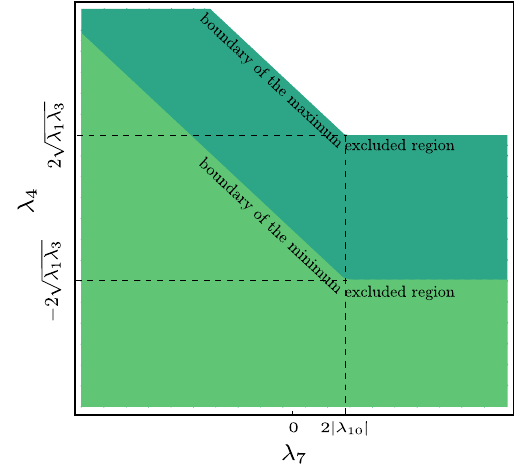
Fig. 2 The maximum excluded region for λ 4 is defined by λ 4 ≤ √ √ λ λ λ ≥ 2 | λ | , and λ ≤ 2 λ λ + 2 | λ | − λ 2 1 3 for 7 10 4 1 3 10 7 for λ < 2 | λ | , whereas the minimum excluded region is defined by √ √ 7 10 λ ≤ − 2 λ λ λ ≥ 2 | λ | , and λ ≤ − 2 λ λ + 2 | λ | − λ 4 1 3 for 7 10 4 1 3 10 7 for λ 7 < 2 | λ 10